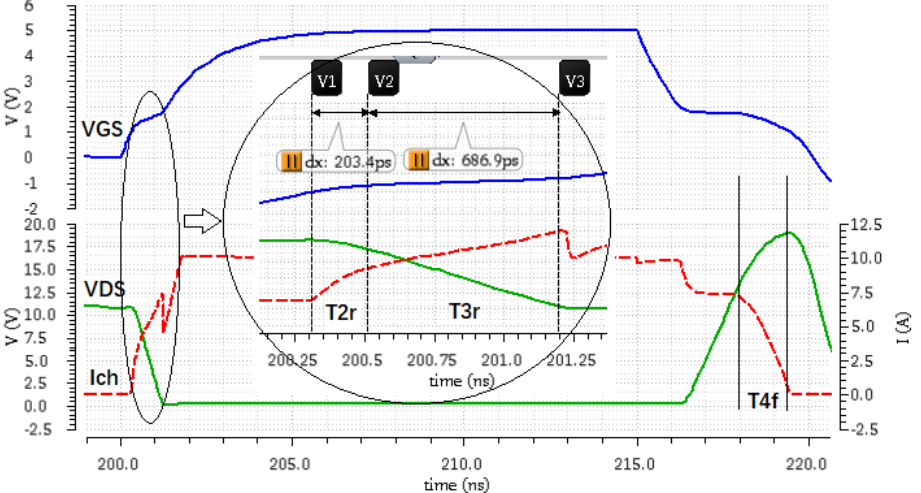
Figure 6. Simulated switching waveforms of V GS , I ch , and V DS in an inductance-limited